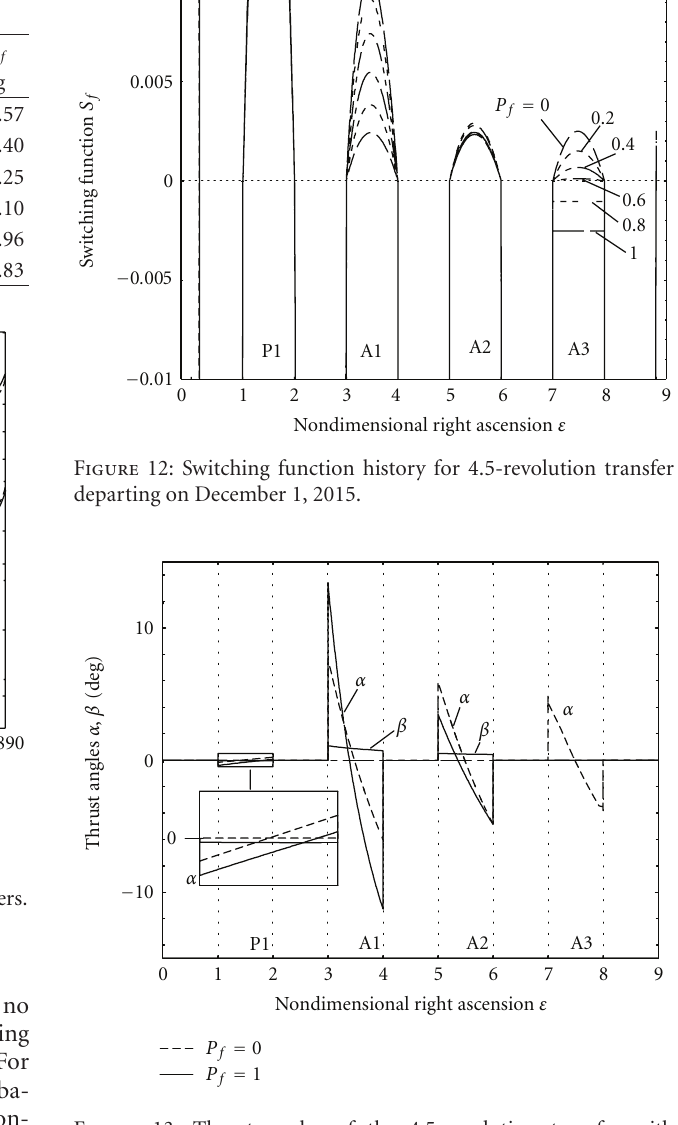
Figure 13: Thrust angles of the 4.5-revolution transfer with departure on December 1,